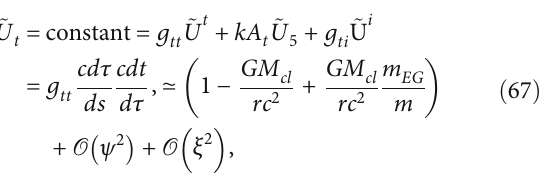
Table 1: Limiting values of scalar, electric, and gravitational potentials and charges, for bodies of electric charge Q and bare mass M ; for static fi elds, ψ ≪ 1 , ξ ≪ 1 , nonrelativistic matter and spherical symmetry. The clothed mass is 4 M /3 . Only leading terms in potentials are shown. The term in electric fi eld energy, M